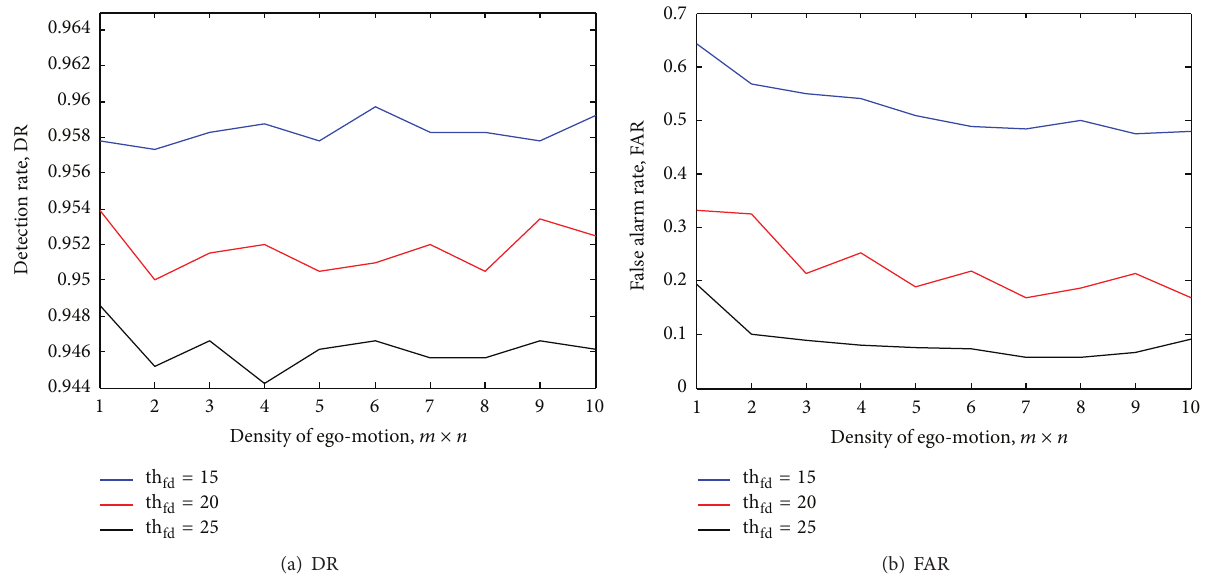
Figure 13: DR and FAR for different density in ego-motion estimation, 𝑚 × 𝑛 , and frame differencing threshold, th fd .